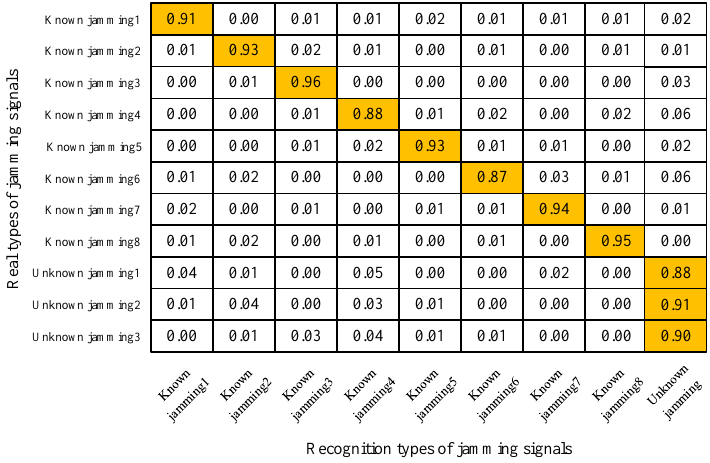
Figure 16. Recognition results of model based on confidence score.